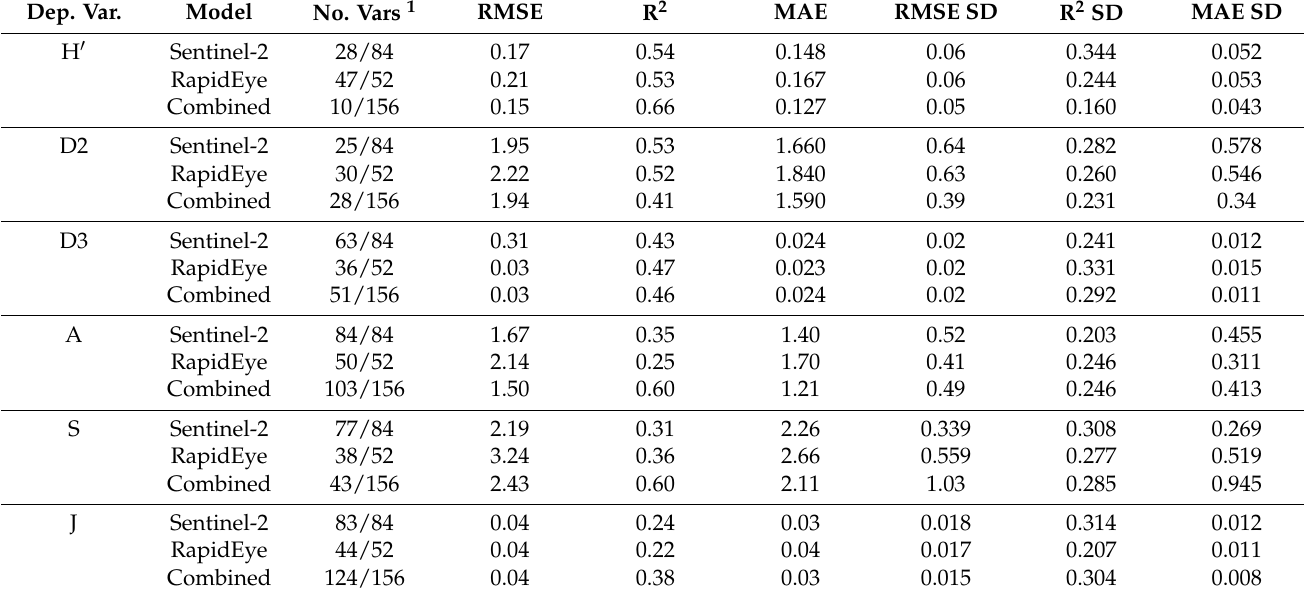
Table 4. Ensemble model training results and error statistics from 10-fold cross-validation, indepen- dent from base ML models, for Sentinel-2, RapidEye, and combined models that included tree canopy height, elevation, and topography data. “SD” refers to the cross-validation standard deviation for model error and goodness of fit